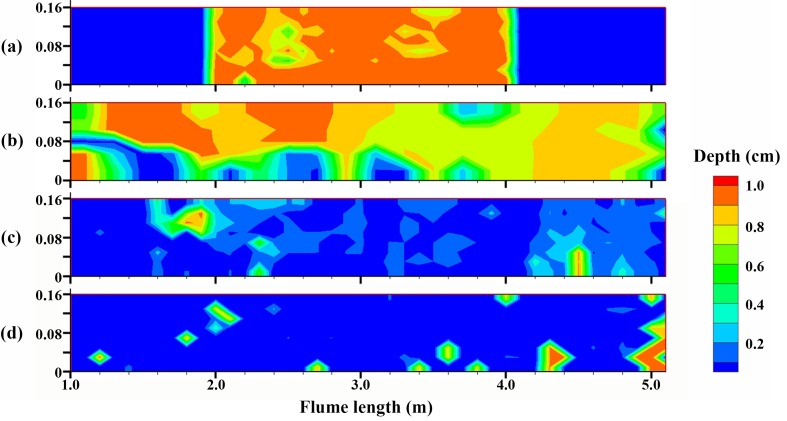
Erosion maps of bio-sediment based on the morphology measurement in the region from 1 m to 5 m.Different colors represent different erosion depths; (a) clean sediment, (b) 5 days, (c) 10 days and (d) 15 days of biofilm growth.